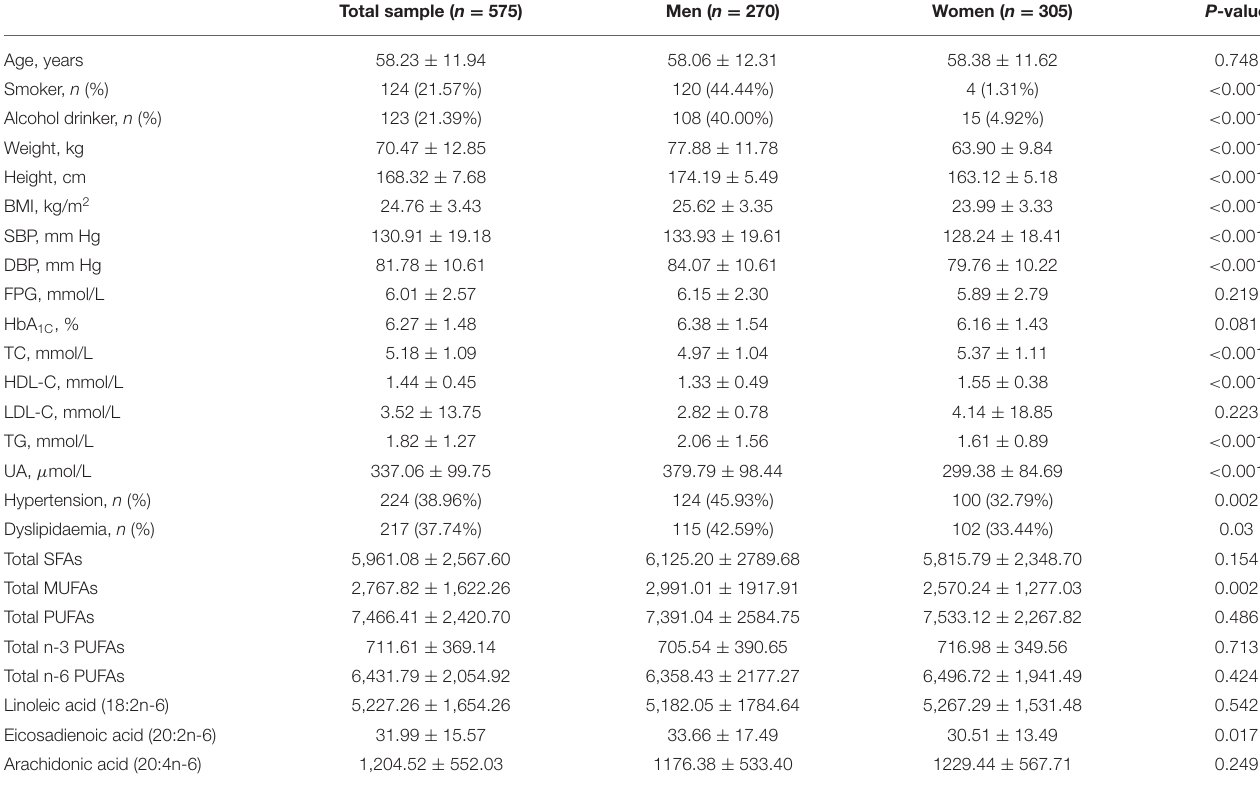
TABLE 1 | Basic characteristics of studied